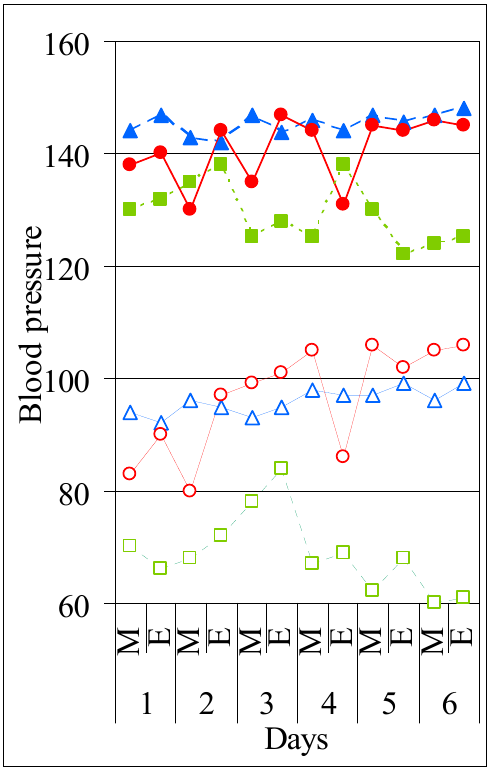
Figure 11. Blood pressure variation in the morning (M) and evening (E). ( ▲ )—Coxswain systolic; ( Δ )—Coxswain diastolic; ( ● )—Mechanic systolic; (o)—Mechanic diastolic; ( ■ )—Sailor systolic and ( □ )—Sailor diastolic.